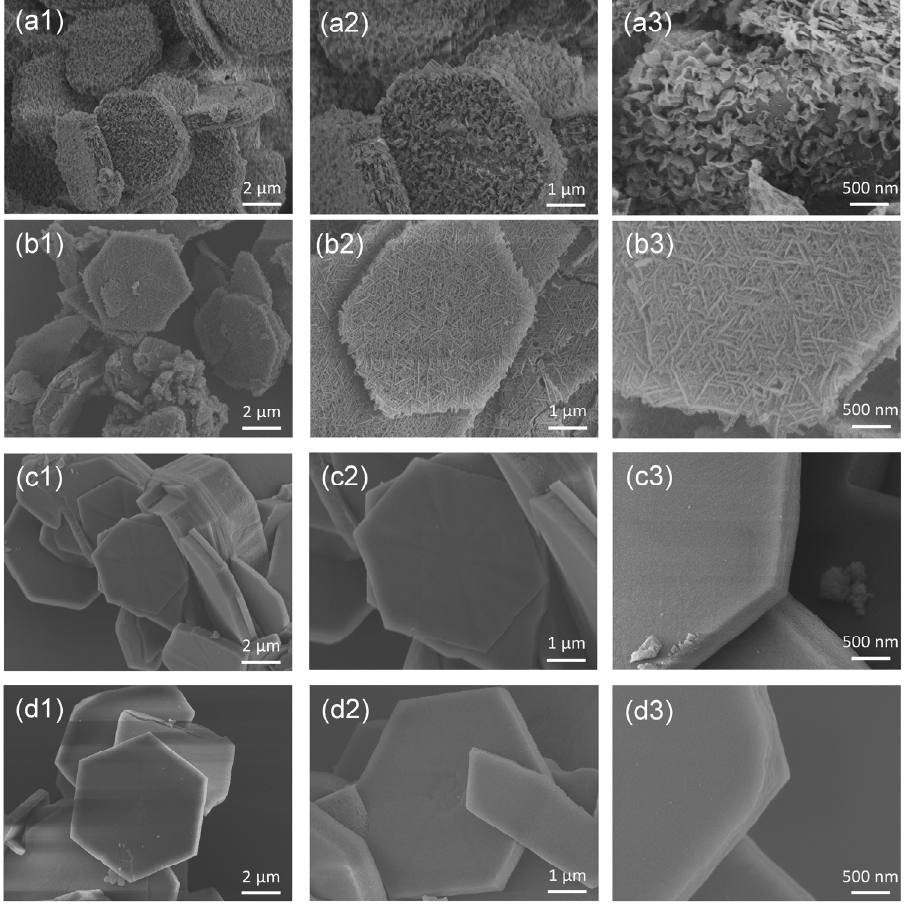
Figure 1. SEM images of Ni-MOF produced at different reaction temperatures, ( a1 – a3 ) Ni-MOF-60; ( b1 – b3 ) Ni-MOF-80; ( c1 – c3 ) Ni-MOF-100, and ( d1 – d3 ) Ni-MOF-120. ( b1 – b3 ) Ni-MOF-80; ( c1 – c3 ) Ni-MOF-100, and ( d1 – d3 )